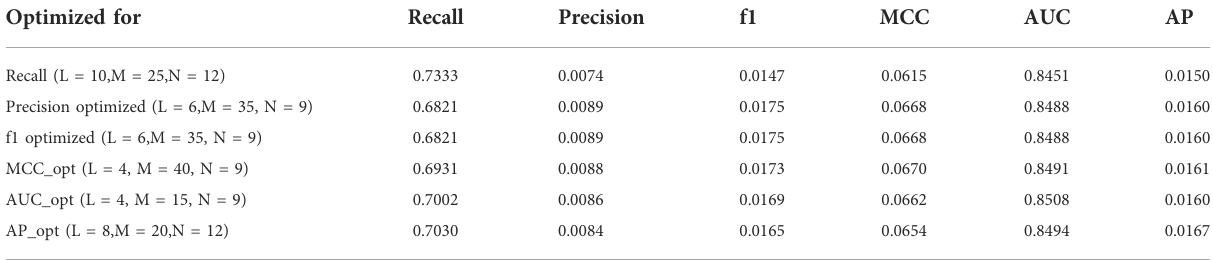
TABLE 1 Hyperparameter optimization results. The columns of the table are the values of each metric for an imbalanced dataset. The rows are the metrics used for optimization and the corresponding optimized hyperparameters. A D 2 thres value of 0.1 (cid:2) A 2 is used here. Optimized for Recall Precision f1 MCC AUC AP